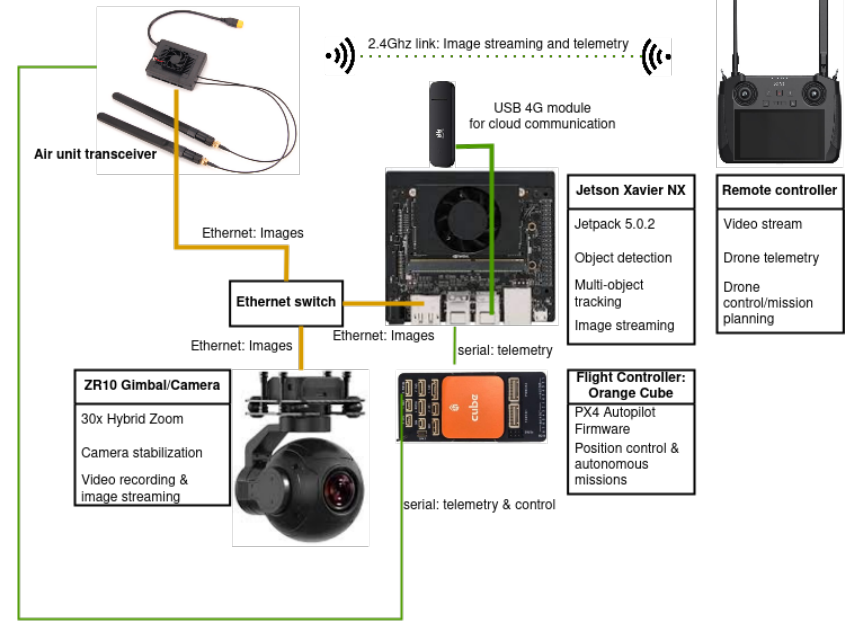
Figure 3. UAV onboard